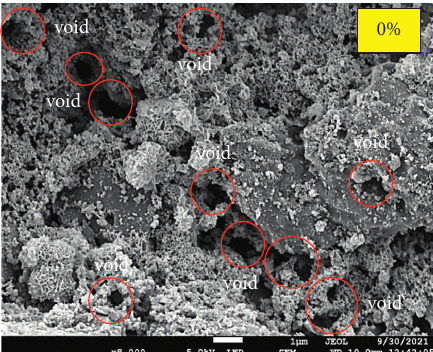
Figure 19: Appearance of many voids in the POC LWAC speci- mens containing 0% spent garnet.